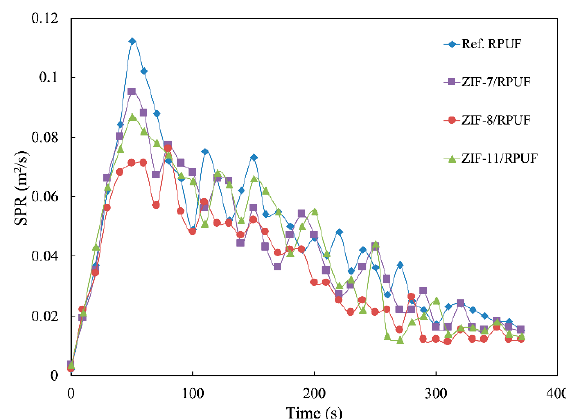
Figure 10. Smoke production rate (SPR) curves of Ref. RPUF, ZIF-7/RPUF, ZIF-8/RPUF and ZIF- 11/RPUF.